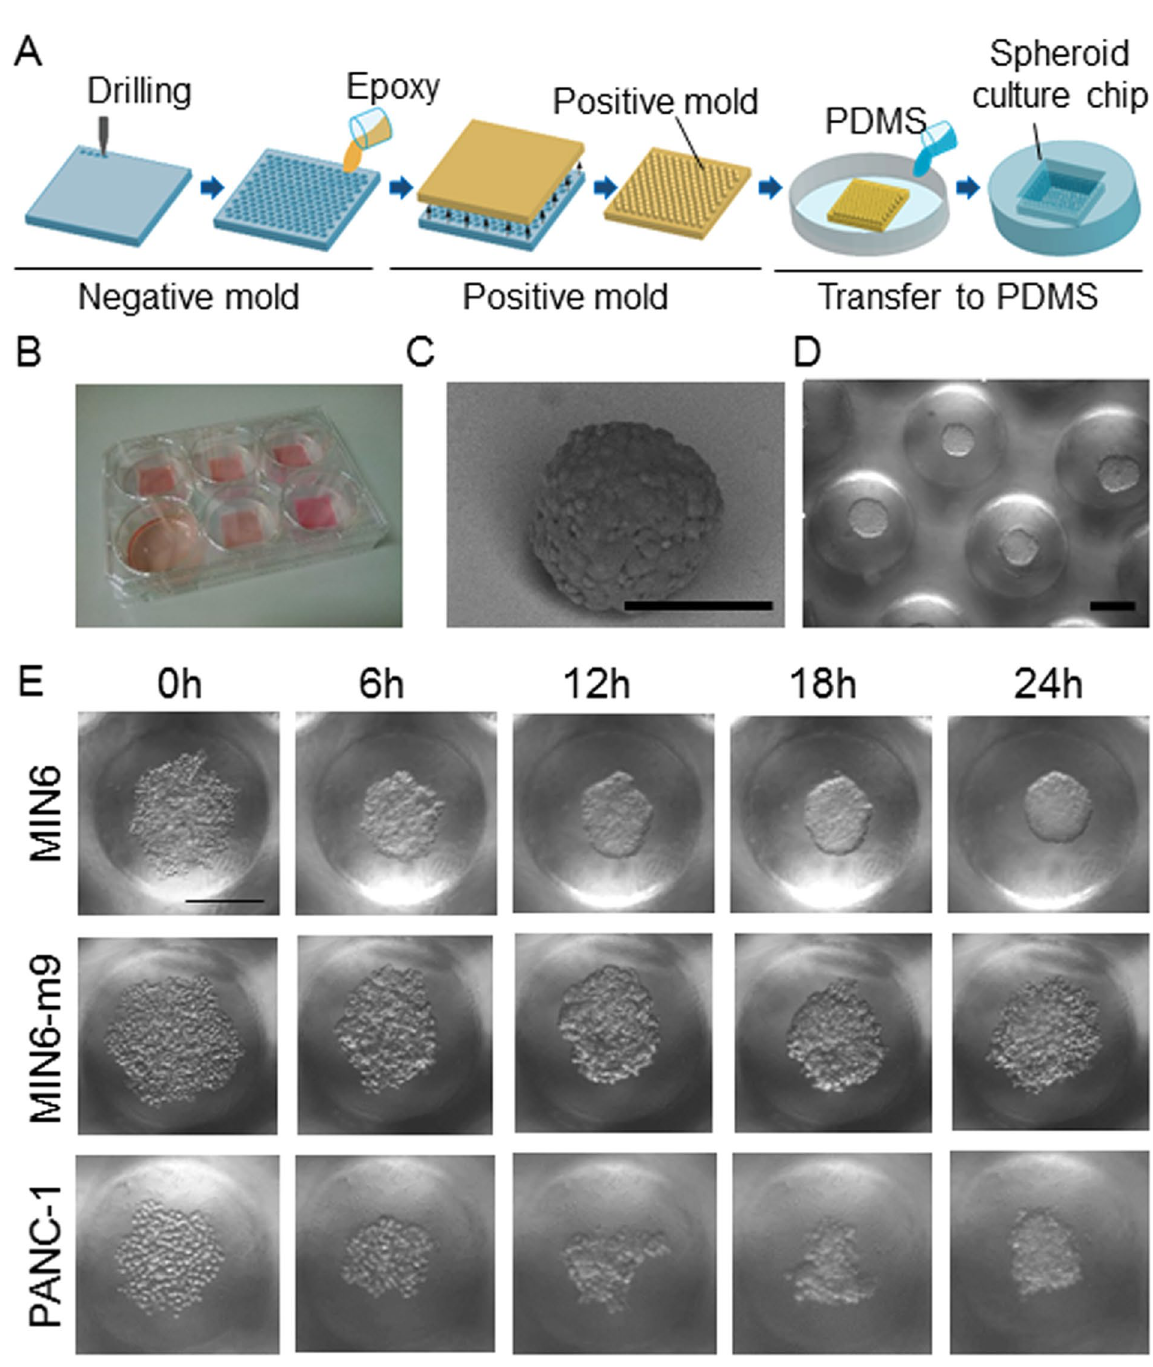
Figure 6. Monitoring of spheroid formation. ( A ) Schematics of the two-step moulding for fabrication of the spheroid culture chip. The chip was made of oxygen-permeable PDMS with 100 microwells ( ϕ 500 μ m). ( B ) The spheroid chips were placed in a 6-well plate. The polystyrene bottoms of the 6-well plate were removed to facilitate oxygen supply through the bottoms of the spheroid chips. ( C ) Scanning electron microscopic image of MIN6 spheroids formed on a spheroid culture chip. The scale bar is 200 μ m. ( D ) Representative eRC-CMS image of MIN6 spheroids on the chip. The scale bar is 200 μ m. ( E ) Time-lapse imaging of spheroid formation. MIN6, PANC-1, and MIN6-m9 cells in randomly selected microwells were continuously monitored with eRC- CMS after seeding. The scale bar is 200 μ